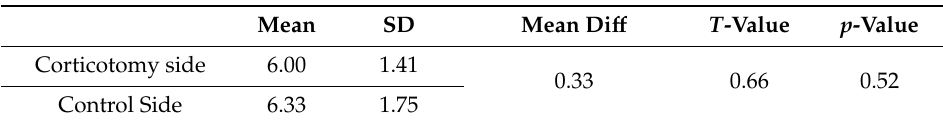
Table 5. Comparison of the amount of Molar rotation in the partial corticotomy side and the control side (to the nearest 0.5 degrees).